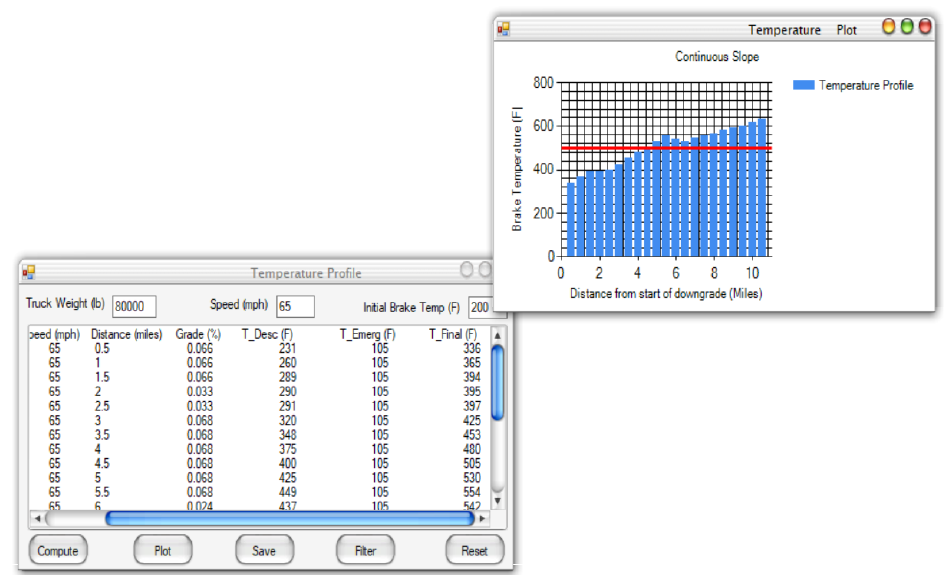
Figure 5: Temperature profile and plot along the downgrade